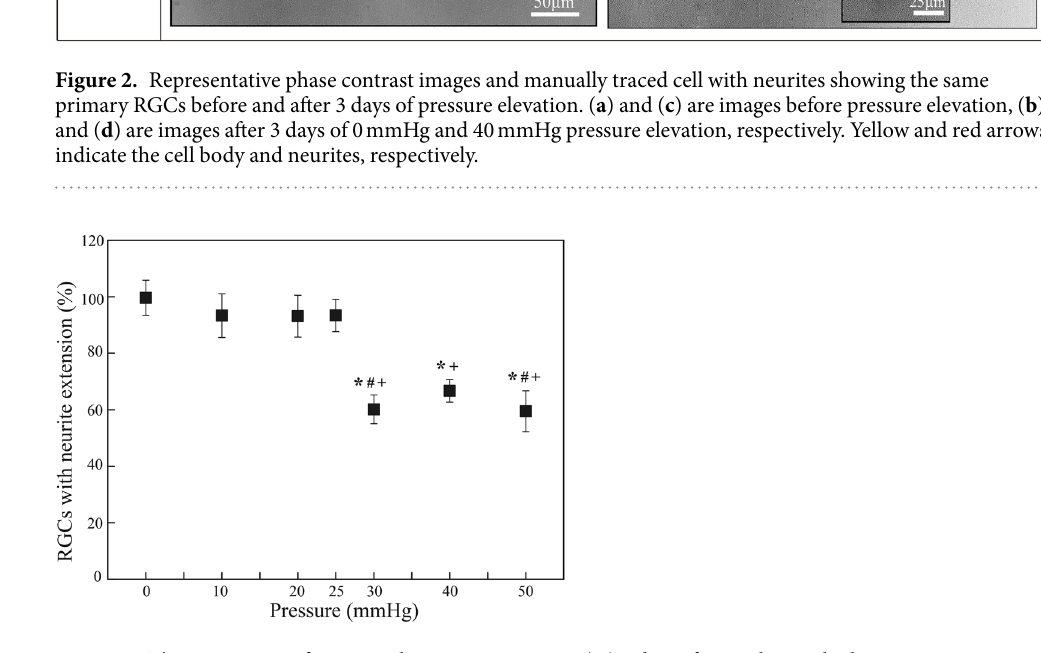
The axons of RGCs, which are the sole retinal neuron projections that form the optic nerve connecting the eye to the brain 50 , was defined as the longest neurite extending from the RGC cell body. Figure 5 shows the percentage change in axon length (i.e. the difference in axon length on day 3 minus the length on day 0, divided by the length measured on day 0) at different pressure levels. Similar to the change in total neurite length meas- urements, under pressures of 0 mmHg, 10 mmHg, and 20 mmHg, axon lengths increased by 52.29 ± 7.75 μ m, 24.12 ± 8.67 μ m, and 19.01 ± 3.82 μ m, respectively (mean ± SEM), after 72 hours of pressure treatment. Under 25 mmHg and 30 mmHg, axon length only increased by 3.26 ± 4.15 μ m, and 3.46 ± 7.70 μ m, respectively; and under 40 mmHg and 50 mmHg, axon length significantly decreased by 18.57 ± 10.32 μ m and 30.67 ± 9.95 μ m, respectively. Overall, the axon length decreased by 1.65 ± 0.18 μ m for each mmHg increase in pressure, while controlling for the differences of baseline axon lengths between pressure groups (linear mixed model, p < 0.001).